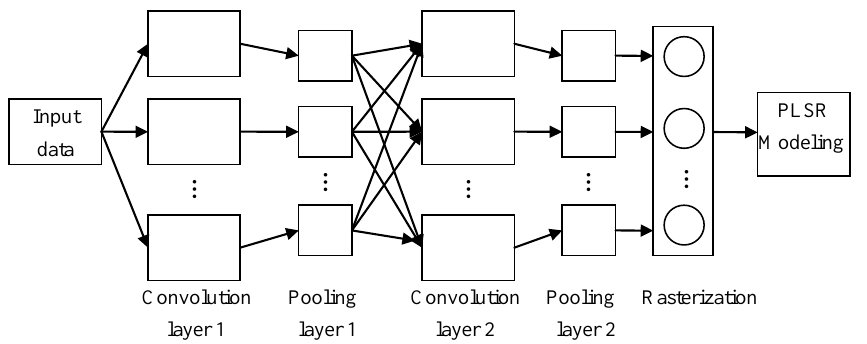
Figure A1. Matlabcode for training set and validation set separation of 106 orange samples.